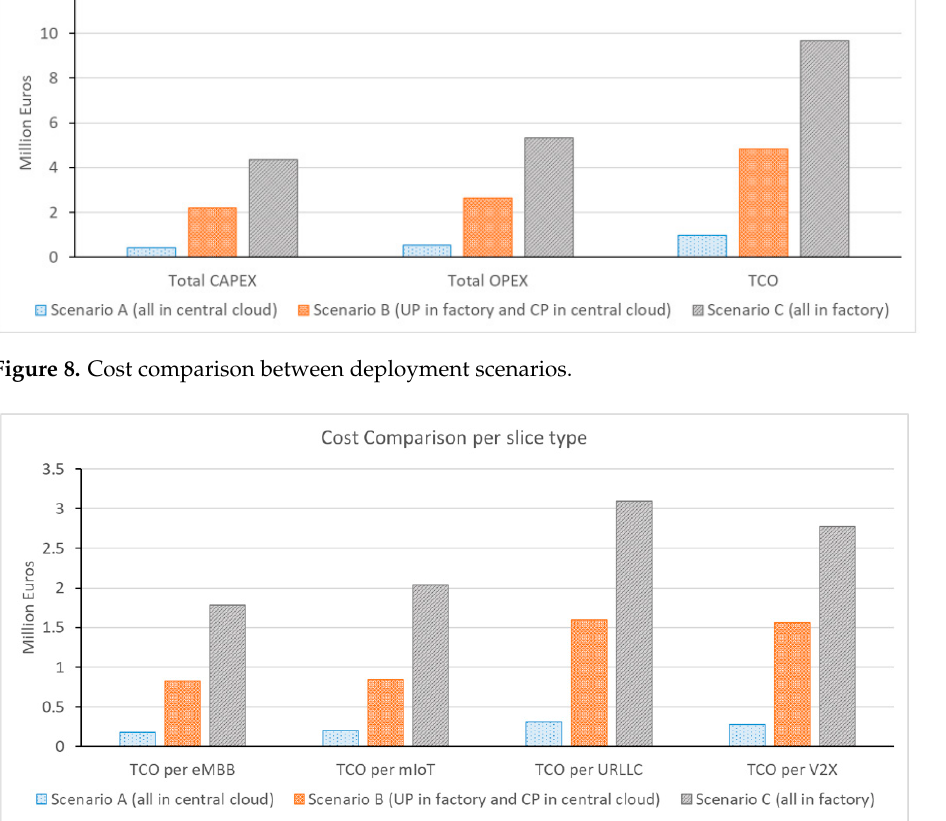
Figure 9. Cost comparison between different slice types and deployment scenarios.